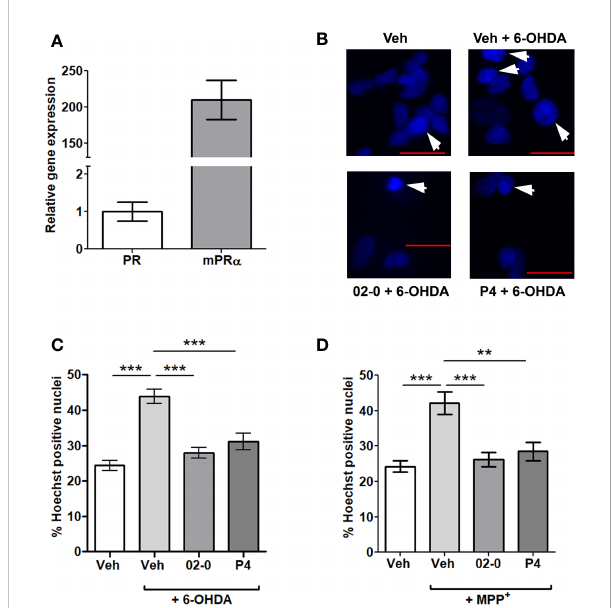
FIGURE 1 PR and mPR a expression and the effects of P4 and 02-0 treatments on 6-OHDA- and MPP + -mediated cell death in SH-SY5Y cells. (A) Gene expression of PR and mPR a in SH-SY5Y cells. N=6. (B) Representative images of SH-SY5Y cell nuclei labeled with Hoechst 33342 in the 6-OHDA experiment. Nuclei in which chromatin appears compacted and were counted as positive are indicated by an arrow. Scale bar: 20 m m. (C) Assessment of cell death in SH-SY5Y cells in the Hoechst assay following 24h Veh, 100 nM 02-0 and 100 nM P4 treatments in the presence or absence of 50µM 6-OHDA. N=18. One-way ANOVA results: p<0.0001. Tukey ’ s multiple comparisons test results: ***: p<0.001. (D) Assessment of cell death in SH-SY5Y cells following Veh, 100 nM 02-0 and 100 nM P4 24 h treatments in presence or absence of 750 nM MPP + . N=18. One-way ANOVA results: p<0.0001. Tukey ’ s multiple comparisons test results: **: p<0.01: ***: